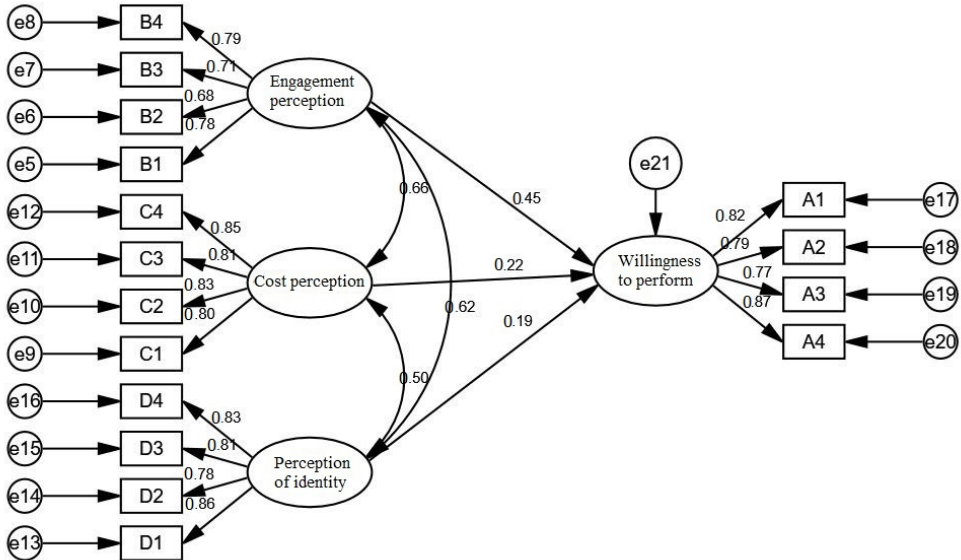
Figure 4. Structural equation model normalized path estimation.